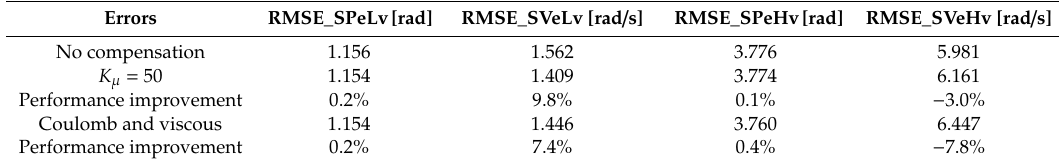
Table 6. Position and velocity tracking error comparison with payload 3 .